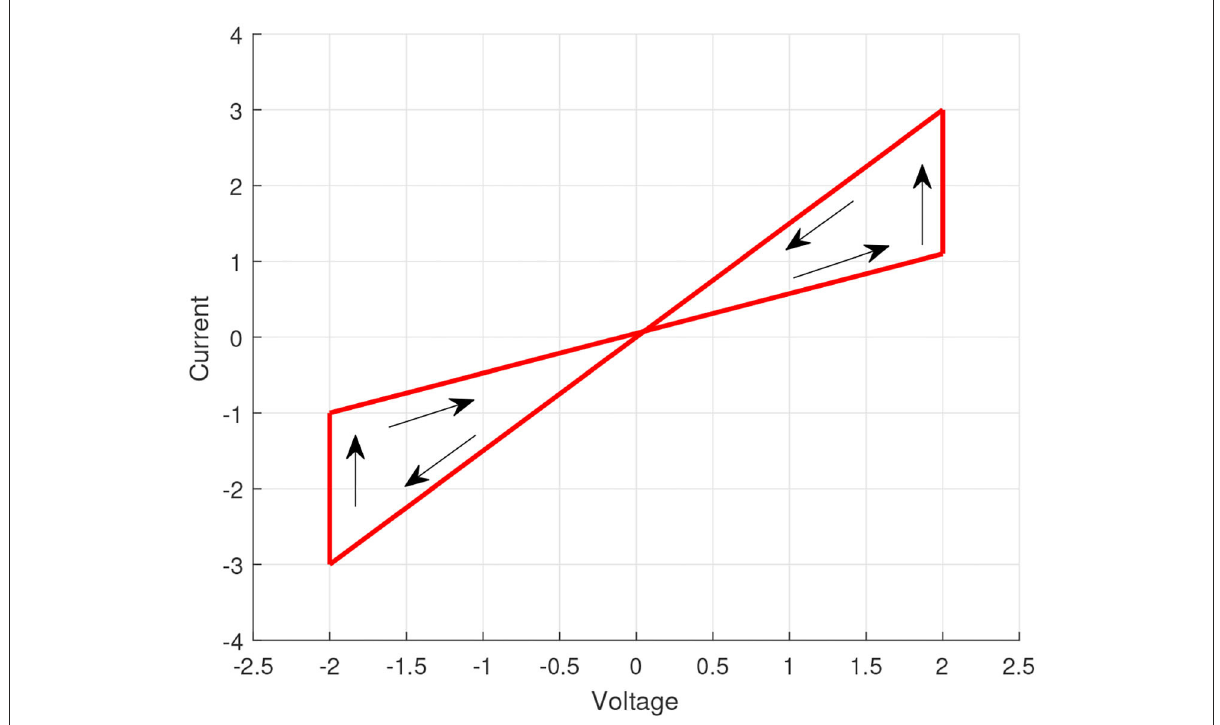
FIGURE1 Typical current-voltage characteristic of a